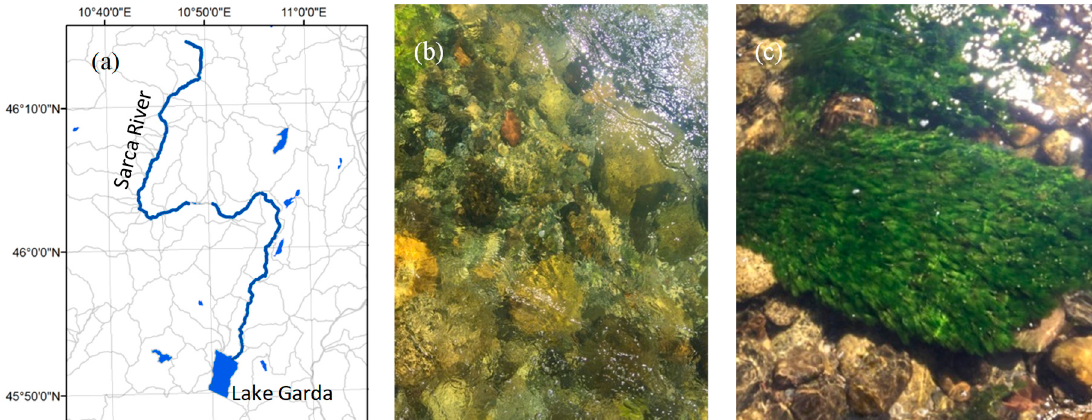
Figure 1. (a) The Sarca River located in Northeast Italy and main bottom types including (b) gravels Figure 1. ( a ) The Sarca River located in Northeast Italy and main bottom types including ( b ) gravels composed of dolomite and (c) patches of submerged aquatic vegetation (SAV). composed of dolomite and ( c ) patches of submerged aquatic vegetation (SAV).